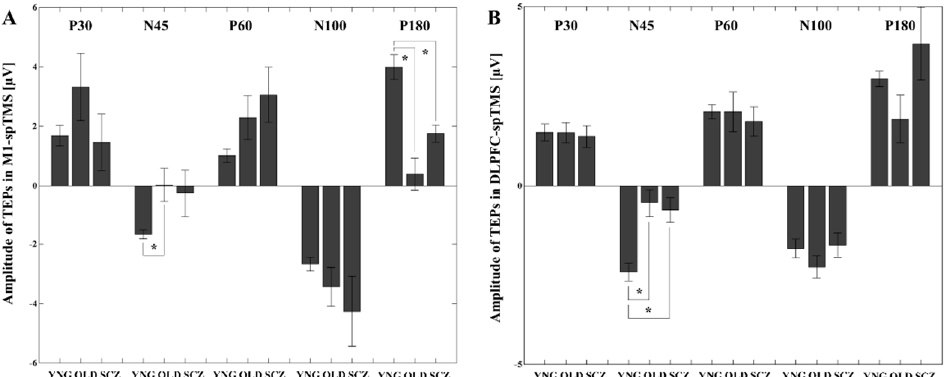
Figure 2. Amplitude differences for each TMS-evoked potential (TEP) component among healthy young (YNG), older (OLD), and patients with schizophrenia (SCZ) at the left central (LC) ROI (left M1). TEP amplitude differences among the groups at the left M1 induced by M1-spTMS were demonstrated in ( A ), while TEP amplitude differences among the groups over the left DLPFC induced by the DLPFC-spTMS are shown in ( B ). Compared to the YNG group, the OLD group had a significantly lower amplitude of the N45 TEP, while the OLD group and SCZ group had significantly lower amplitudes on the P180 TEP over the LC ROI (left M1) in M1-spTMS paradigm. In the DLPFC-spTMS, compared to the YNG group, the OLD group and SCZ group had significantly lower amplitudes on N45 TEP over the left frontal ROI (left DLPFC). * Significant